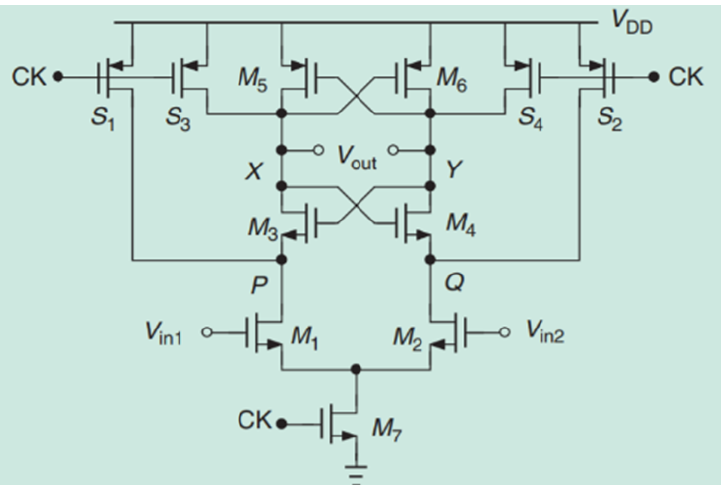
Figure 12. StrongARM